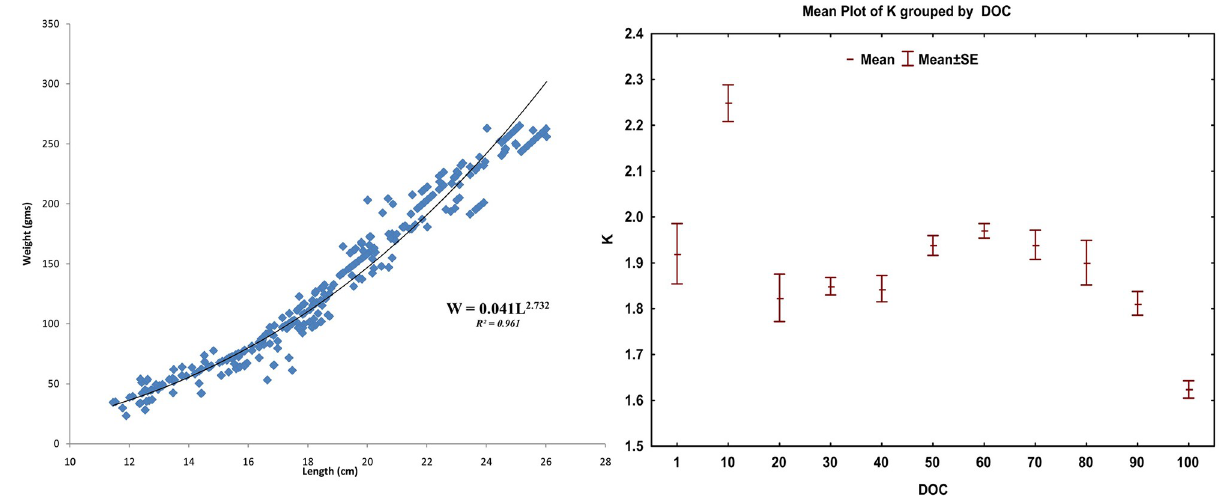
Fig 4. The length-weight relationship and variation in condition factor (K) during growout operation of Silver pompano.